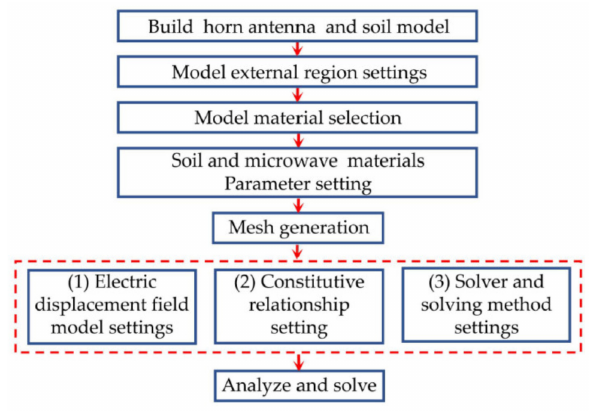
Figure 1. Simulation flow